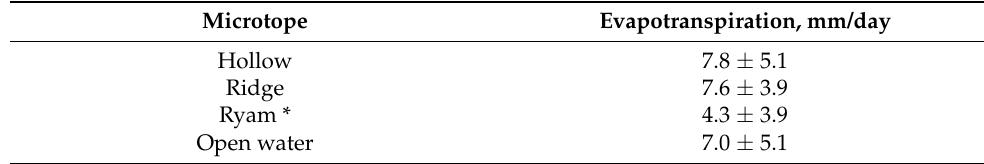
Table 1. Evapotranspiration values for the different